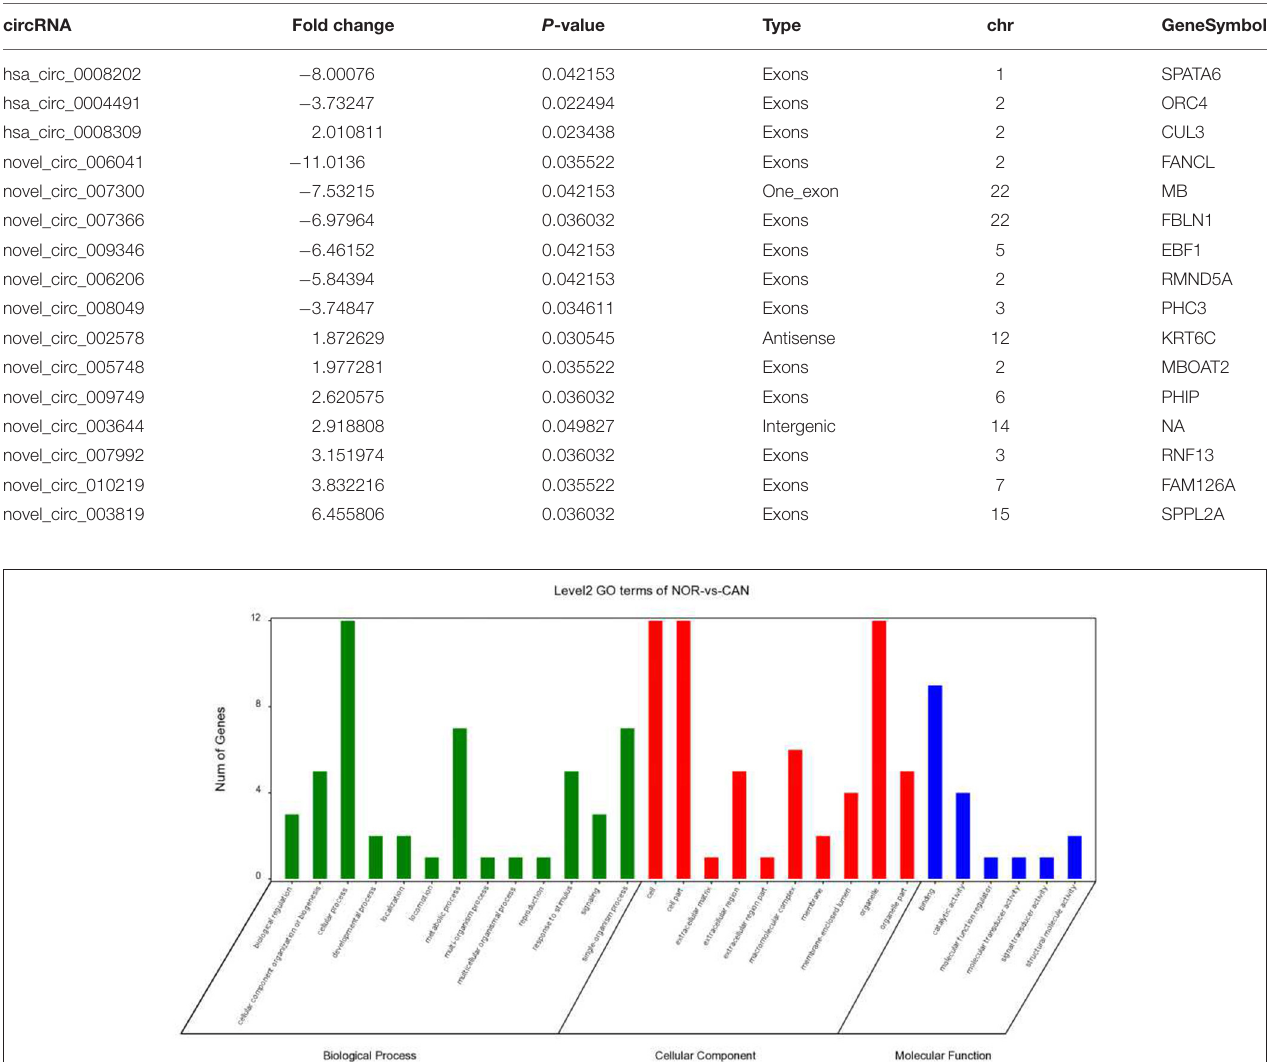
TABLE 1 | 16 differently expressed circRNAs in the oral squamous cell carcinoma. circRNA Fold change